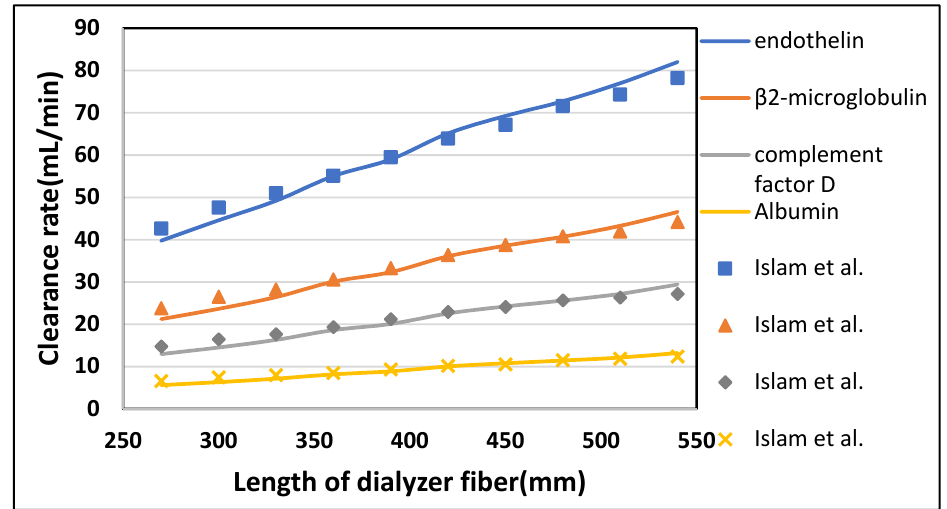
Figure 10. The clearance rate of high molecular weight solutes plotted against varying length of the dialyzer at Q B = 300 mL/min and Q D = 500 mL/min.